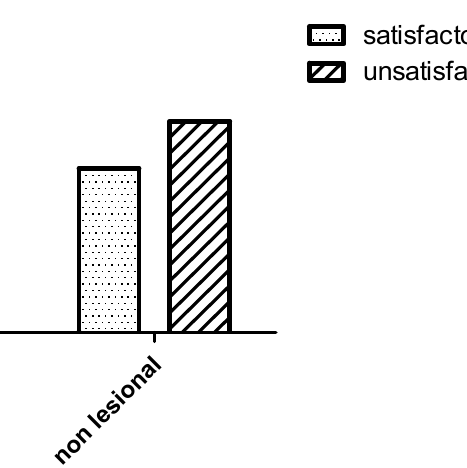
Figure 2. Bar graph showing clinical outcome between lesional and non lesional extratemporal epilepsies patients. There was no difference in the clinical outcome between lesional and non lesional patients (Fischer exact test, p = 0.15). Satisfactory (Engel class I–II) and unsatisfactory (Engel class III–IV) outcome one year after surgery.